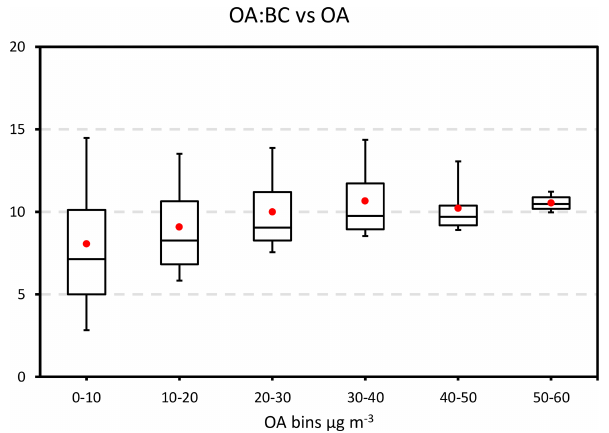
Figure 4. OA : BC mass ratio, shown using 10, 25, 50, 75, and 90th percentiles with means in red, composited by OA